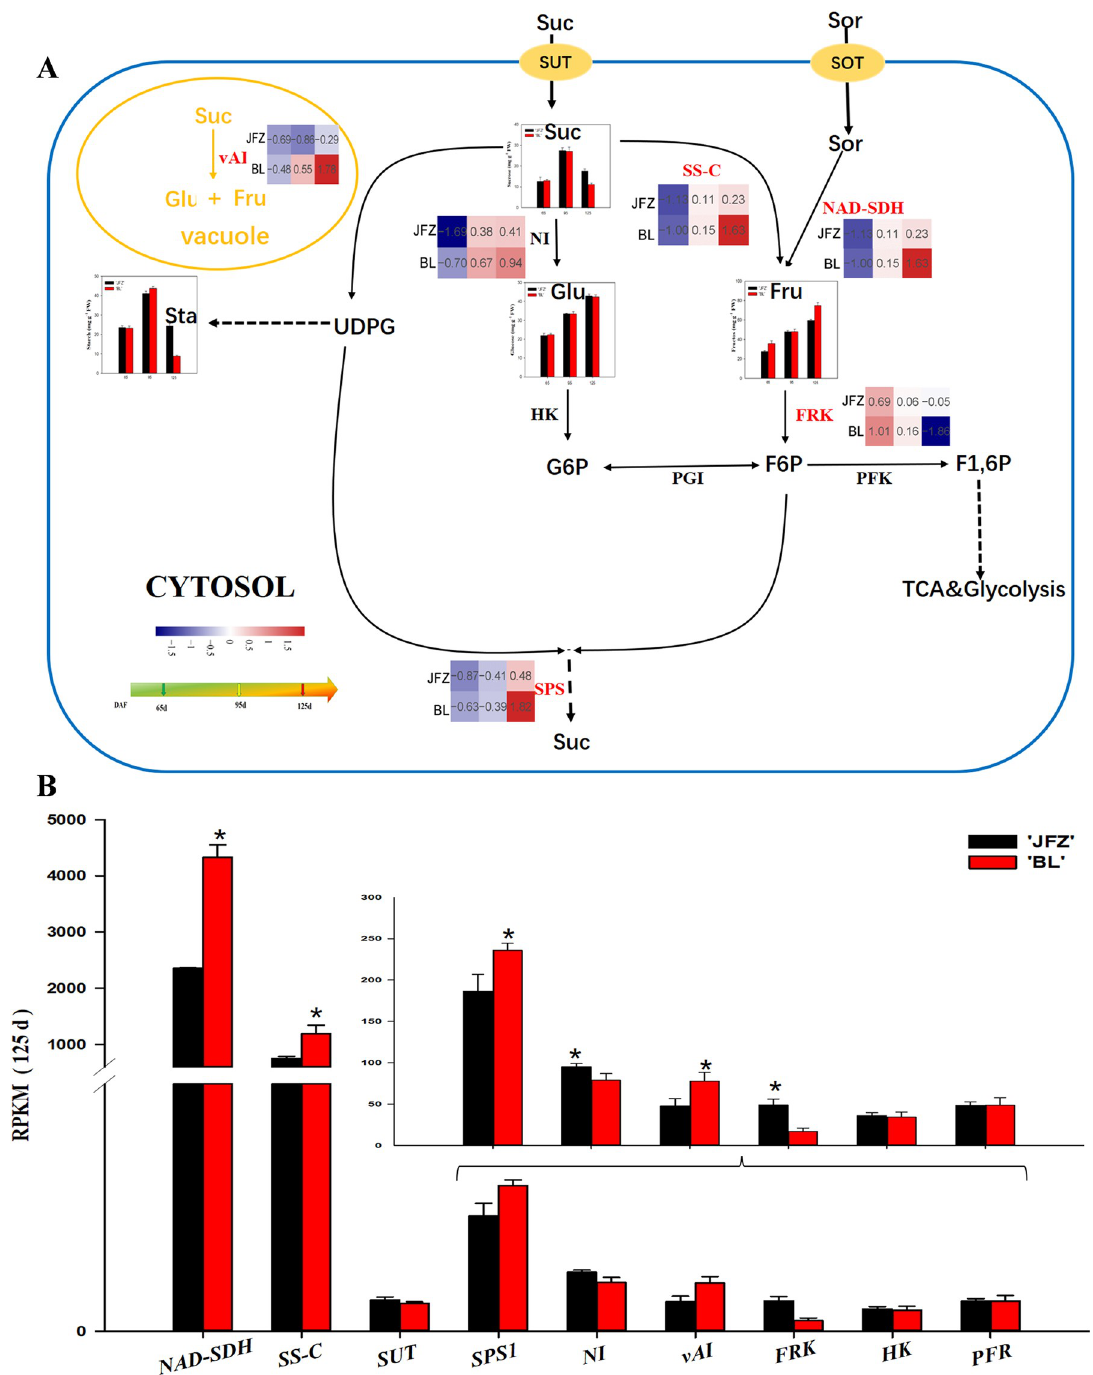
Fig 5. Regulation of main sugar metabolism during loquat fruit development. (A) The transcript level trends were determined using log2-transformed TMT values. The contents of fructose, sucrose, and glucose are shown in columns. The color of heat map from blue to red represents gene transcript levels from low to high. (B) Transcript level analysis of genes involved in sugar metabolism of two loquat cultivars at 125 DAF. Differences among the samples were analyzed by two (cultivars) × three (sampling dates) ANOVA. The asterisks represent P < 0.05. Each point represents the mean ± SD (n = 3). RPKM: reads per kilobase per